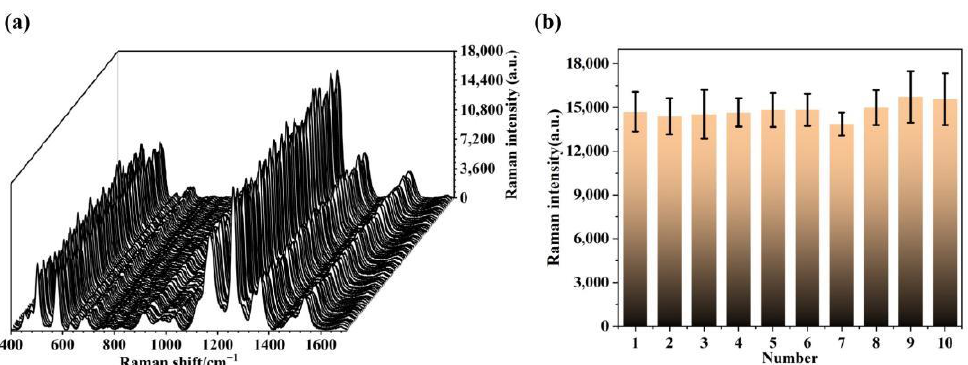
Figure 8. ( a ) SERS spectra of 10 − 7 M TBA-MDA at 80 random points on the SERS chip ( b ) SERS intensities at 1272 cm − 1 acquired from 10 independently fabricated SERS chips.